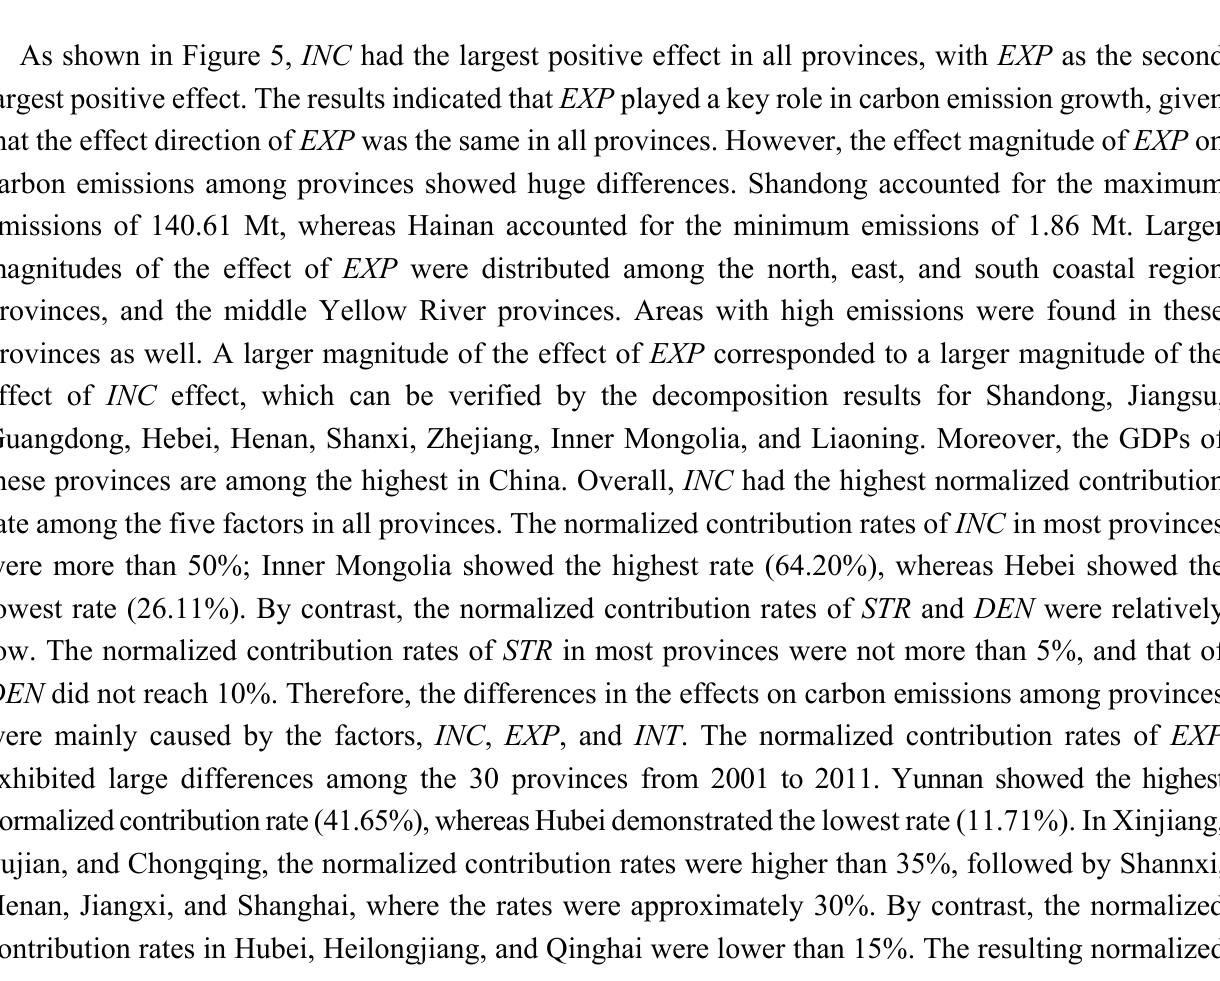
Figure 5. Effects of the factors on all of the provinces from 2001 to